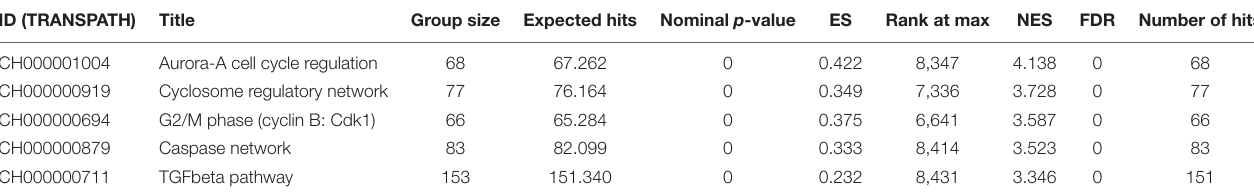
FIGURE 1 | Functional enrichment analysis of differentially expressed genes (DEGs). (A) Enrichment for known disease gene networks in different diseases. Y -axis represents enriched ontology categories and X -axis represents gene ratio. Gene ratio is count/set size. The “count” is the number of genes that belong to a given gene set, while “set size” is the total number of genes in the gene set. Y -axis is sorted based on leading edge. Leading edge is a subset of genes that contributes most to the enrichment score. The dots are sized based on gene ratio and are colored according to their adjusted p- value. (B) Enrichment for hallmark gene sets in the molecular signature database similar to (A) . TABLE 2 | Pathway enrichment using the TRANSPATH R (cid:13) pathway (2019.3) for differentially expressed